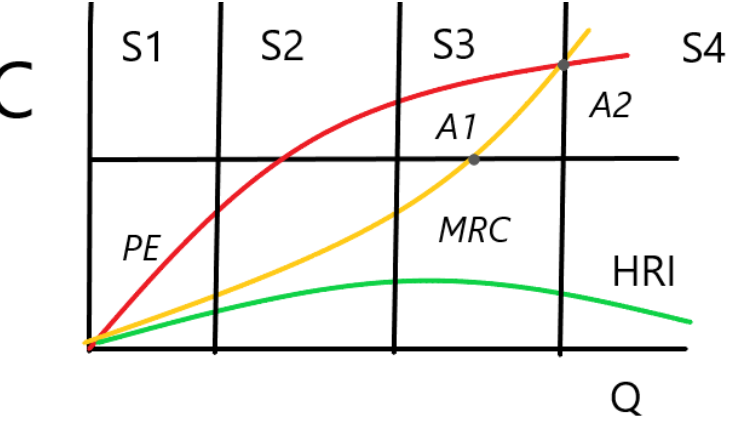
Figure 2. Relationship between investment costs and productivity. Source: own processing based on illustration of Mikhailov et al. (2019, p. 7).